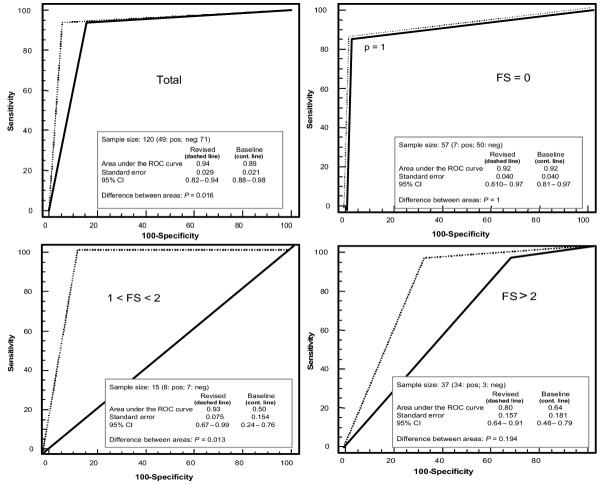
Statistical comparison of the diagnostic performance of the American-European Consensus Group (AECG) criteria for Sjögren's syndrome with baseline and cumulative focus scores (FSs). Receiver operating characteristic (ROC) curves were used to compare the sensitivity and specificity of the AECG criteria with the baseline focus score and with the FS obtained after multilevel histopathological evaluation, with respect to the gold standard of patient re-evaluation by the experienced rheumatologists. The diagnostic performance was significantly improved in the overall series (top left panel; P= 0.016), mostly because of the improvement in the group of patients with 1 ≤ FS < 2 (bottom left; P= 0.013). No difference was observed when FS = 0. No ROC curve could be obtained in the group of patients with 0 < FS < 1, because of the absence of cases classified as Sjögren's syndrome at clinical re-evaluation (positive gold standard). CI, confidence interval.